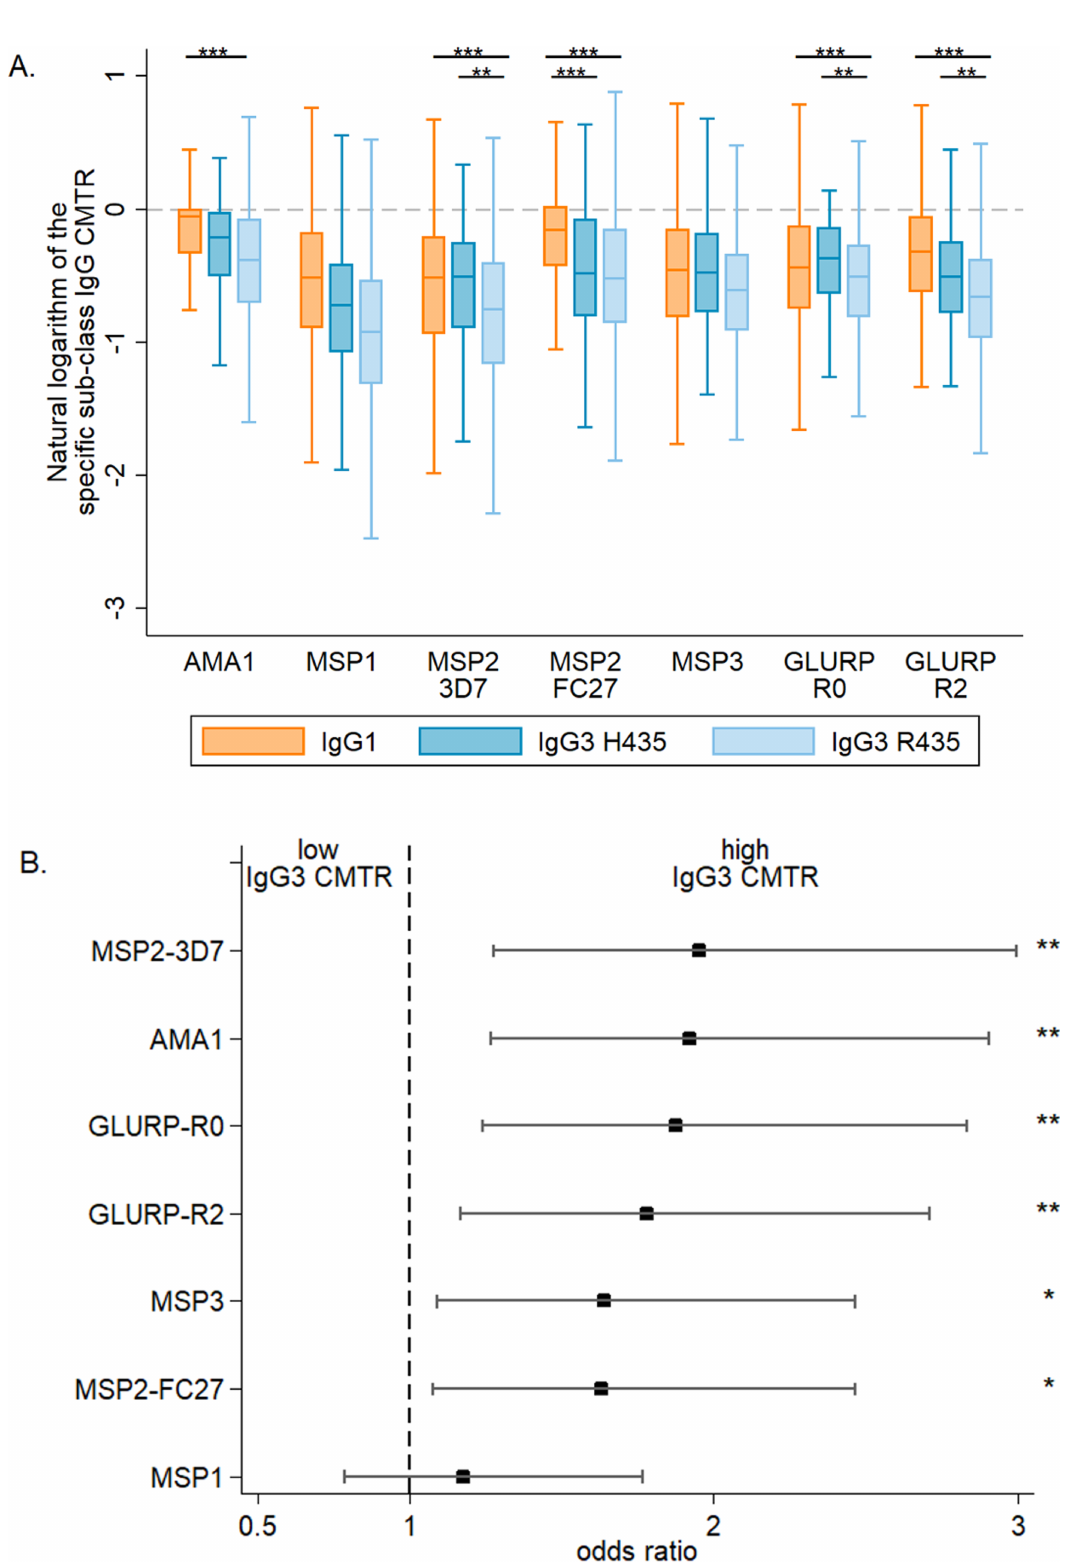
Fig 1. The cord-to-mother transfer ratio of malaria-specific IgG1, IgG3-R435, and IgG3-H435. (A) The cord-to-mother transfer ratios (CMTRs) are represented:malaria-specific IgG1 (orangebars), IgG3 for women with the IgG3-H435 allele